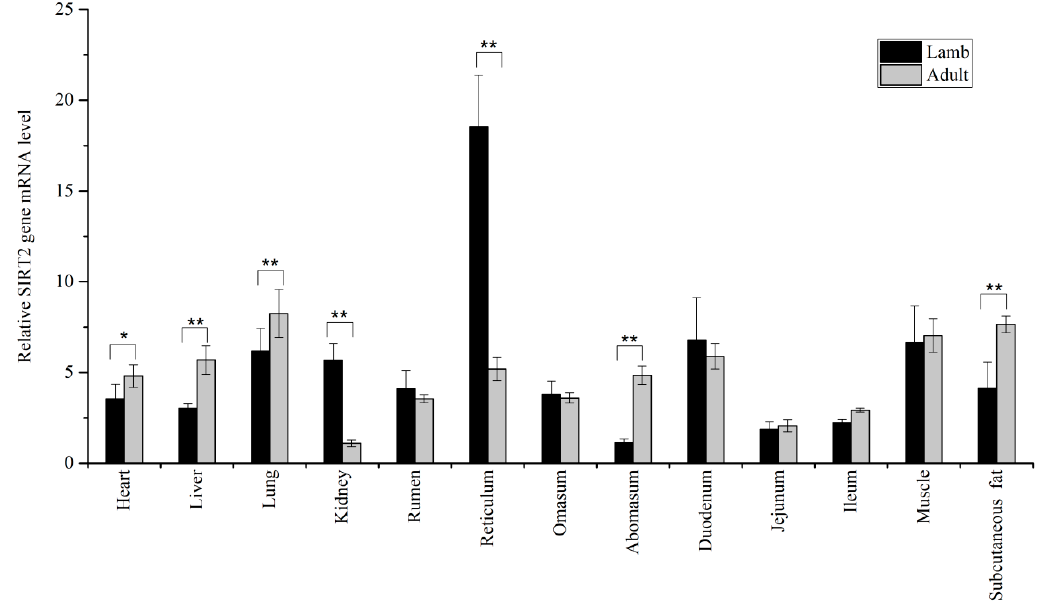
Figure 2. The relative mRNA expression of ovine SIRT2 . * p < 0.05, ** p <